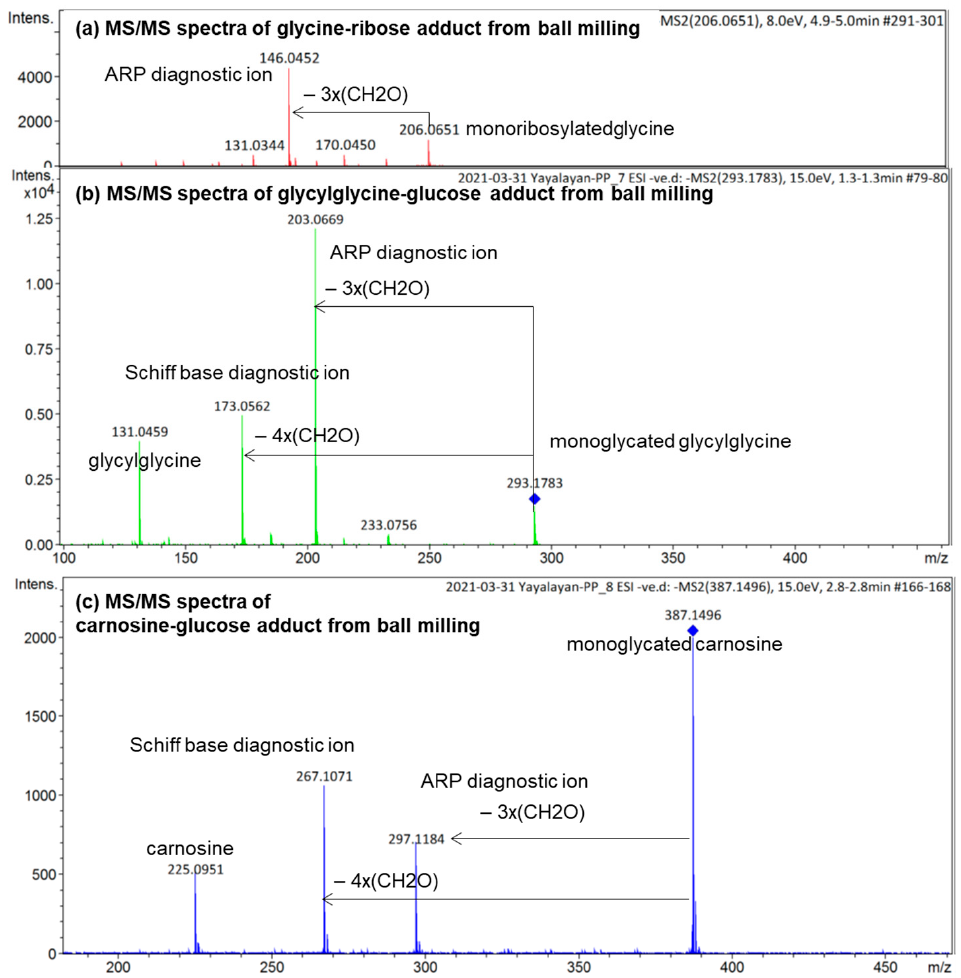
Figure 6. ESI ( − ve)/MSMS spectra of the molecular ion of ( a ) monoribosylated glycine formed in ball-milled glycine/ribose; ( b ) monoglycated glycylglycine formed in ball-milled glycylglycine/glucose; ( c ) monoglycated carnosine formed in ball-milled carnosine/glucose. See Figure 3 for the corresponding MS spectra. All identified ions are deprotonated [M − H] − .